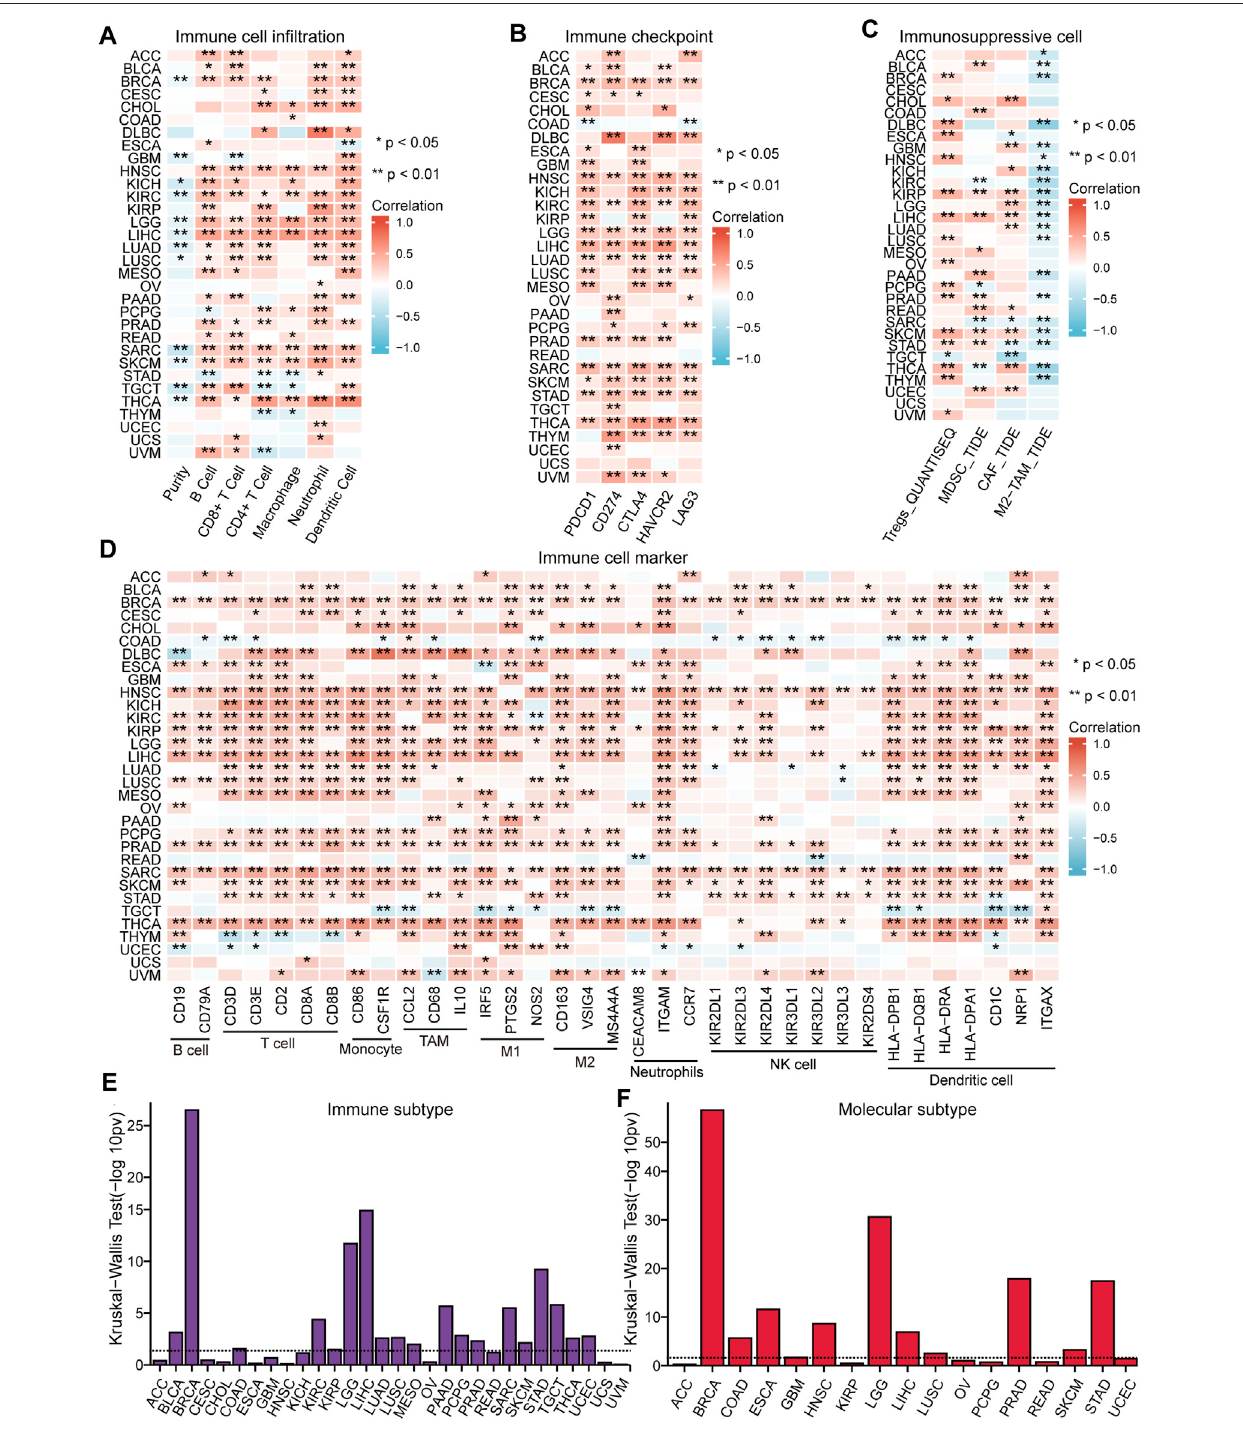
FIGURE 7 | The correlation between NFE2L3 expression and immune feature in pan-cancer. (A) The correlation between NFE2L3 expression and immune in fi ltration in pan-cancer. (B) The correlation between NFE2L3 expression and immune checkpoint in pan-cancer. (C) The correlation between NFE2L3 expression and T cell exclusion fi ltration in pan-cancer. (D) The correlation between NFE2L3 expression and immune cell marker in pan-cancer. (E) The correlation between NFE2L3 expression and immune subtype in pan-cancer. (F) The correlation between NFE2L3 expression and molecular subtype in pan-cancer.